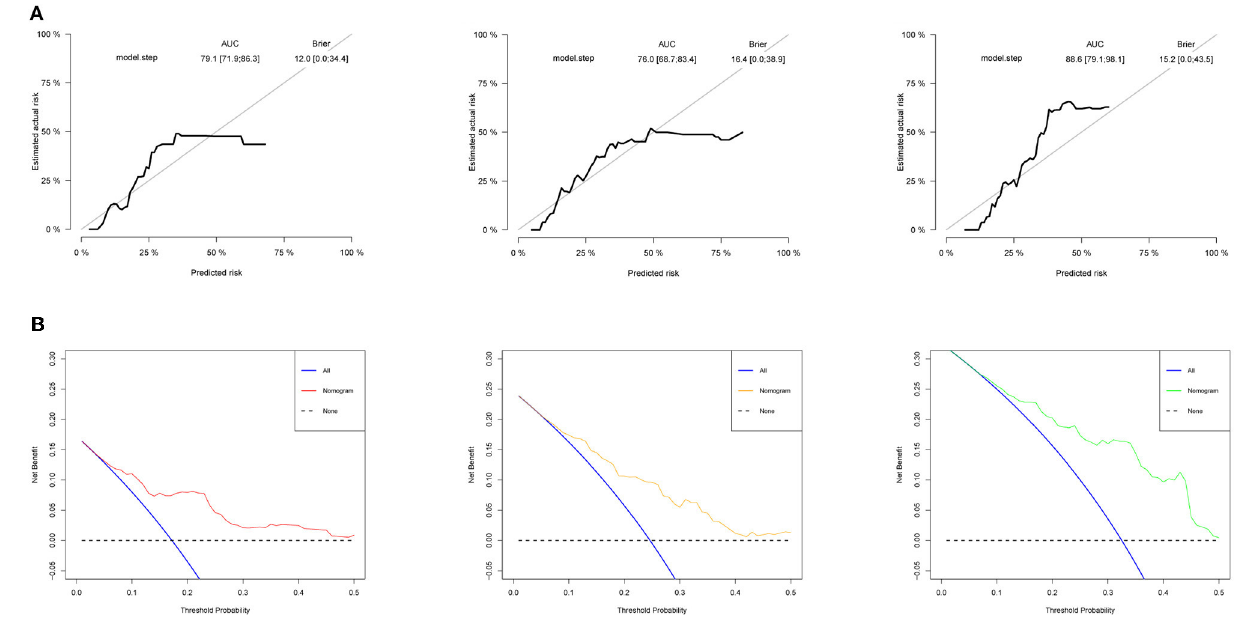
FIGURE 4 | Model performance in the training set. (A) Calibration curves of 16-, 32-, and 48-month specific survival. (B) Decision curve analyses (DCA) for predicting the survival of patients with DOC at 16, 32, and 48 months by nomogram.